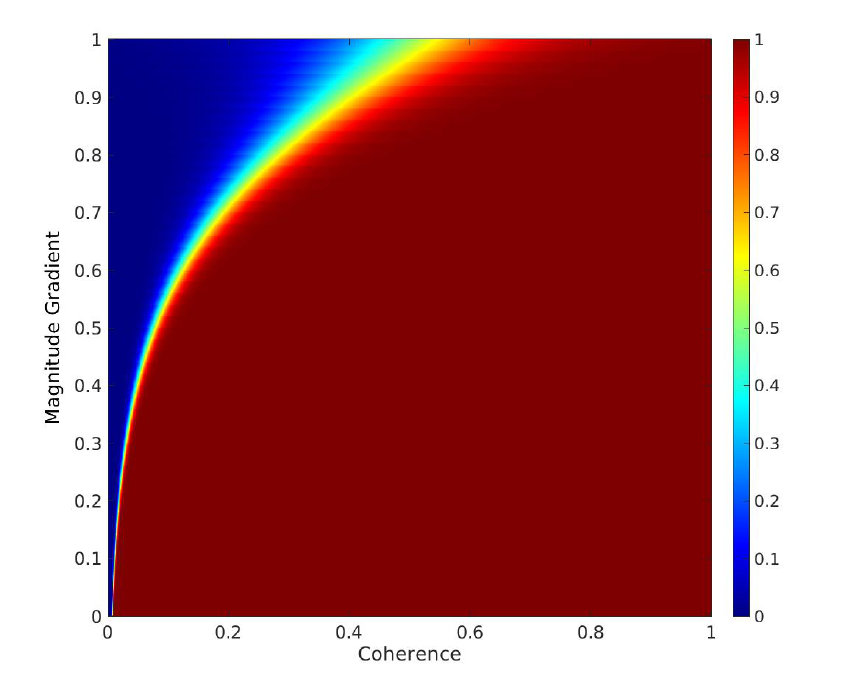
Figure 6. Overlap function S2 example. Red values (i.e., 1) associate the clean interferometric phase as ground truth. Blue values (i.e., 0) associate the original input noisy phase as ground